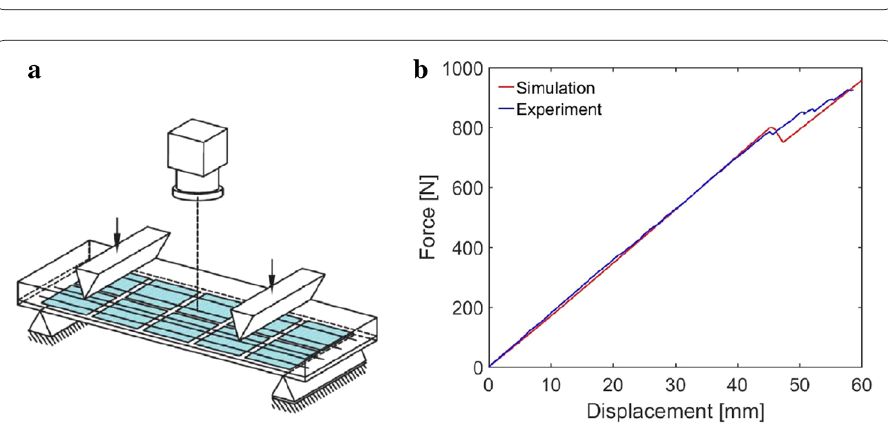
Fig. 17 4-point bending test of a photovoltaic panel. a Experimental test setup, b force displacement curve (from